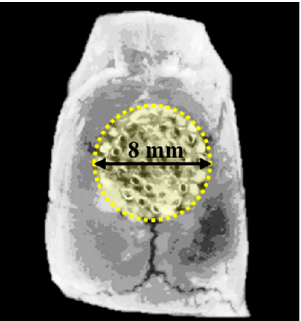
Figure 3. Region of interest (ROI) for micro-computed tomography ( μ CT) analysis.